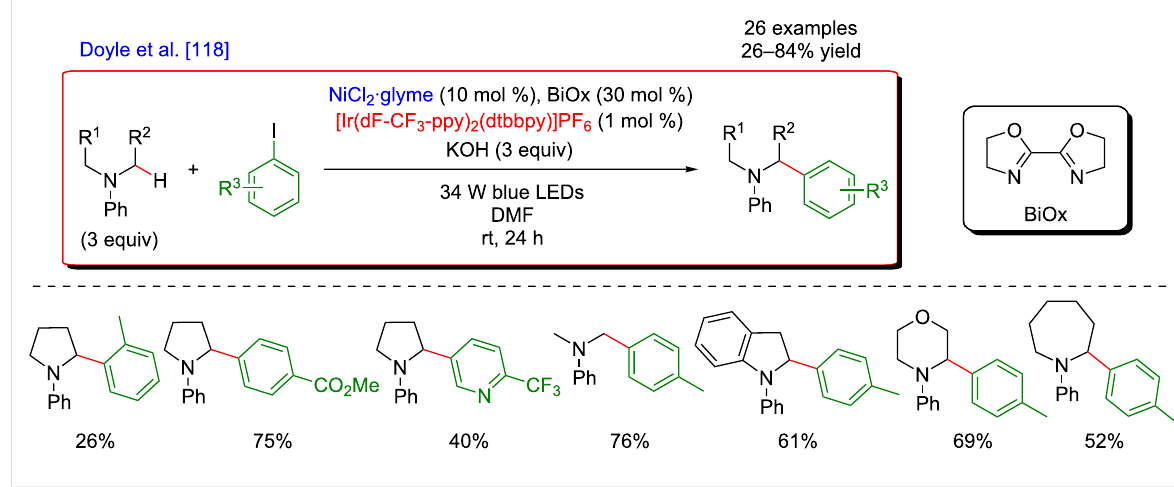
Figure 60: C–H arylation of amines via dual Ni/photoredox catalysis.